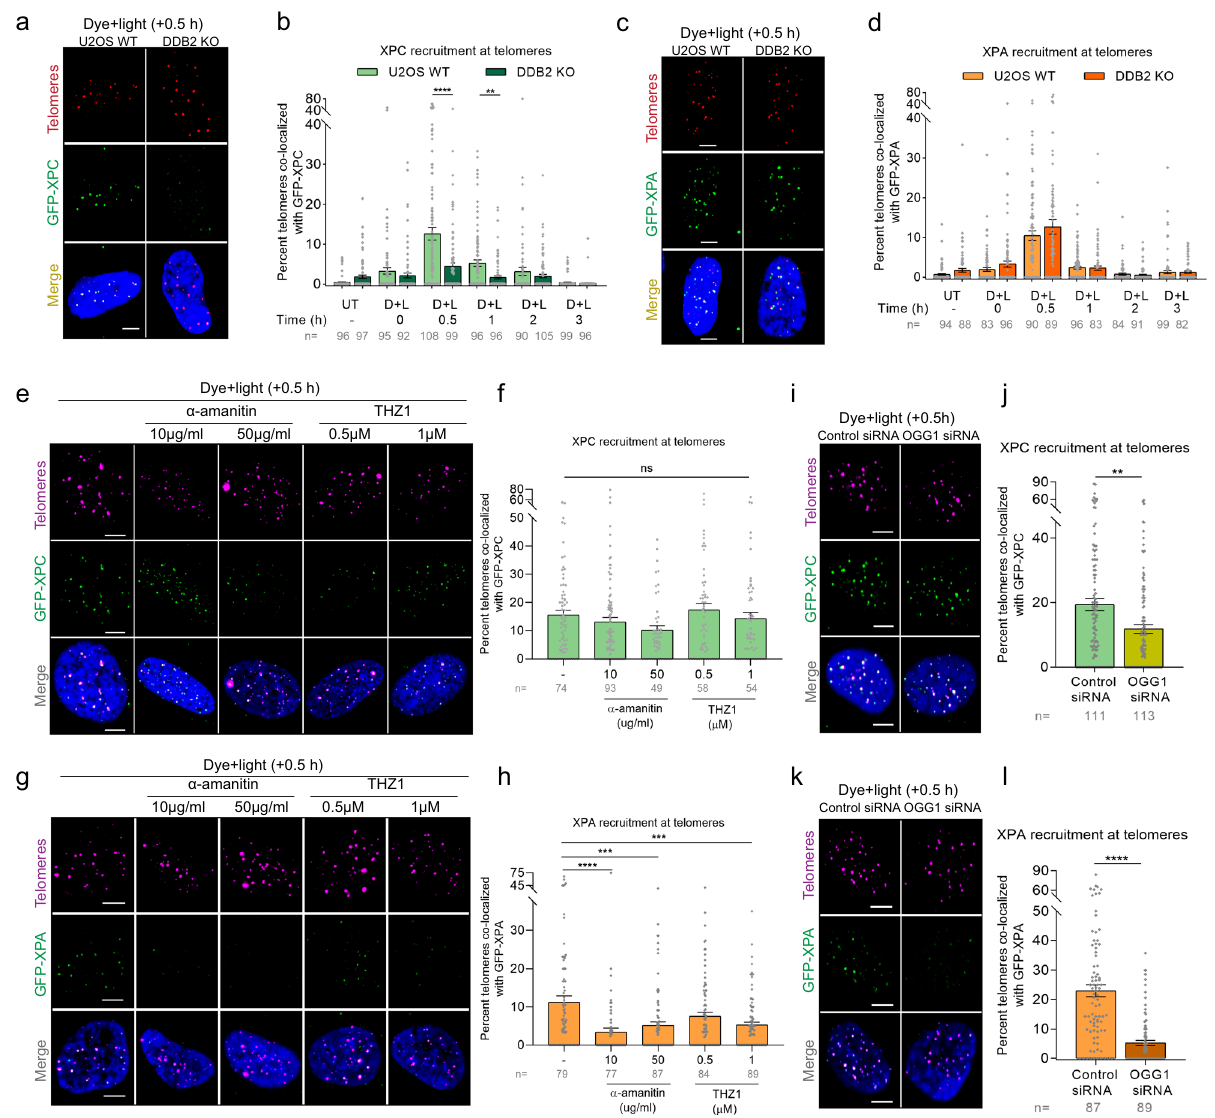
Fig. 3 DDB2 recruits XPC to telomeric 8-oxoG, while XPA recruitment is transcription-coupled and independent of DDB2. a , c Representative images showing recruitment of GFP-XPC ( a ) or GFP-XPA ( c ) to 8-oxoG at telomeres after dye (100 nM, 15 min) plus light (660 nm, 10 min) treatment in U2OS WT and DDB2 KO cells, 30 min post treatment. b , d Percentage telomeres colocalized with GFP-XPC ( b ) or GFP-XPA ( d ) after treatment, over a period of 3 h. e , g Representative images of GFP-XPC ( e ) or GFP-XPA ( g ) accumulation at damaged telomeres 30 min after dye plus light treatment in cells pretreated with transcription inhibitors α -amanitin and THZ1. f , h Quanti fi cation of e ( f ) and g ( h ). i , j Colocalization of GFP-XPC with telomeres after dye plus light treatment in U2OS-FAP-TRF1 cells transfected with control or OGG1 siRNA. k , l Colocalization of GFP-XPA with telomeres after dye plus light treatment in U2OS-FAP-TRF1 cells transfected with control or OGG1 siRNA. Data ( a – l ) represents mean ± SEM from two independent experiments. “ n ” represents the number of cells scored for each condition. One-way ANOVA (Sidak multiple comparison test) ( b , d , f , h ) and Student ’ s two-tailed t -test ( j , l ): ** p < 0.01; *** p < 0.001; **** p < 0.0001. Scale: 5 µ m. Source data are provided as a Source Data fi le. (See also Supplementary Fig.